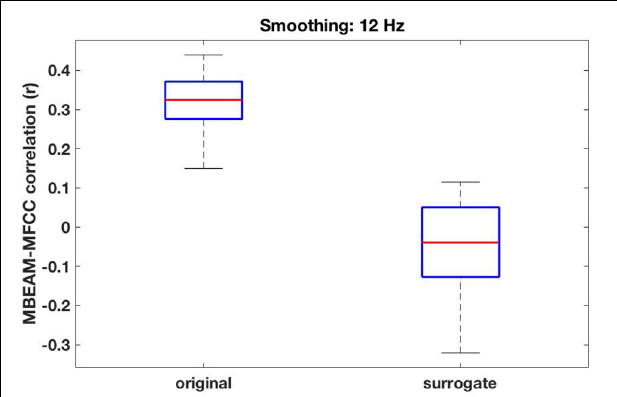
FIGURE 5 | Box plots of the overall global correlation values between the MBEAM and MFCC modulation functions—filtered at 12 Hz—for the 23 speakers, original data on the left , surrogate data on the right .